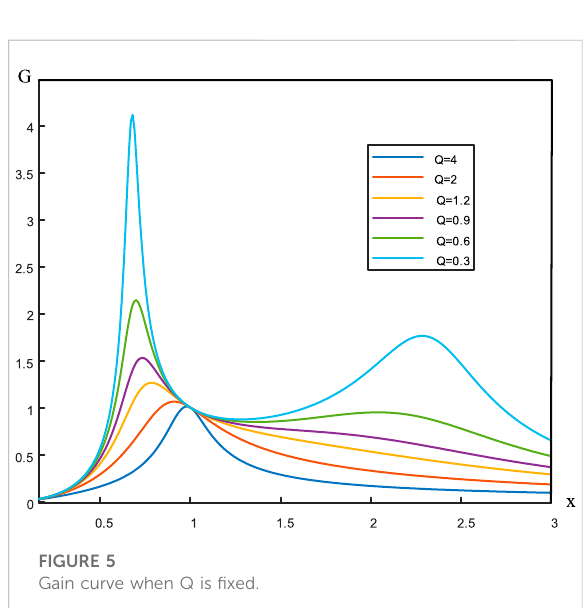
FIGURE 5 Gain curve when Q is fi